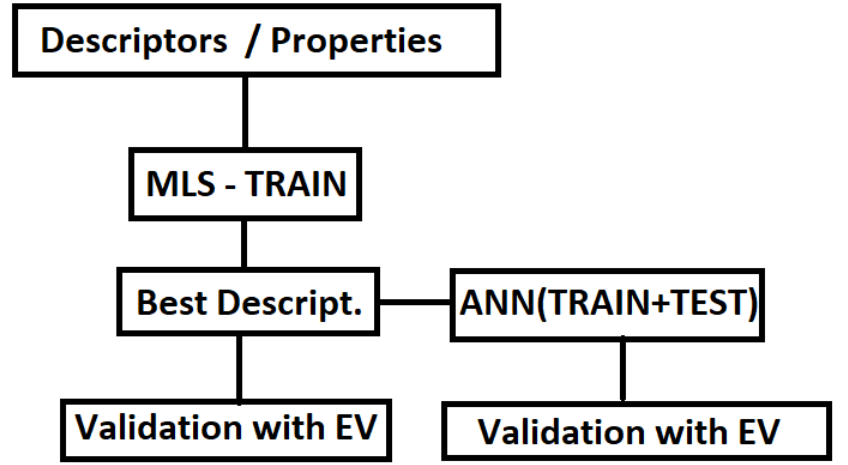
Figure 1. Flow chart of the methodology followed throughout the present work.